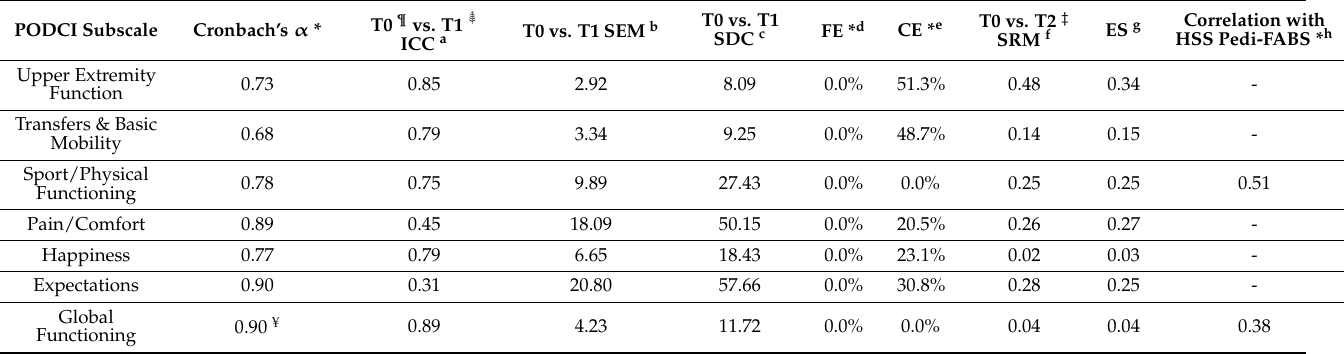
Table 1. Patient demographics and clinical characteristics.